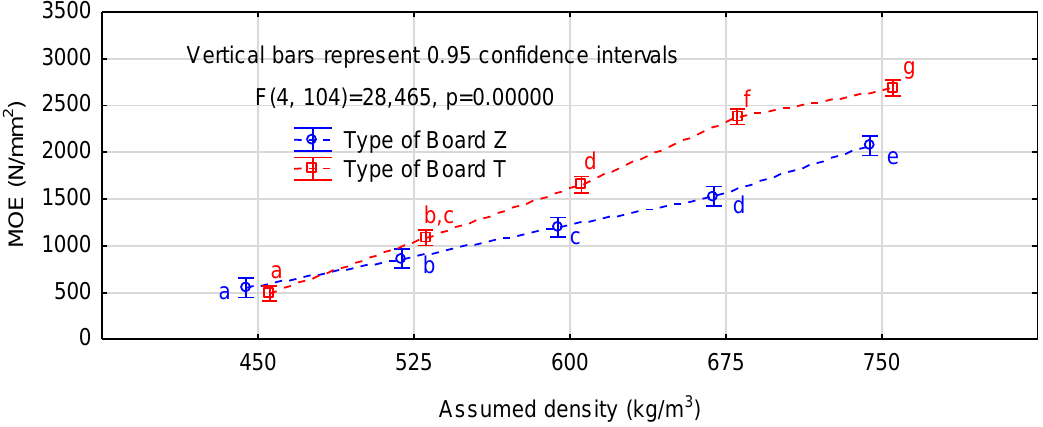
Figure 3. Interaction between density and mat structure and modulus of elasticity of the experimental boards (letters mark homogeneous groups in the HSD Tukey’s test).